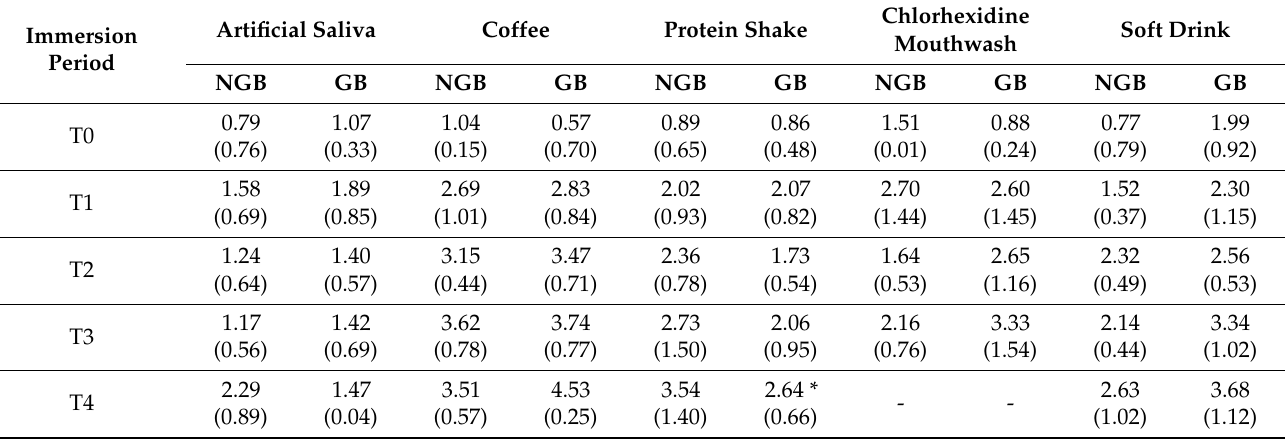
Table 9. ∆ E of high translucent zirconia samples in different mediums at different times; values are expressed as mean (SD).